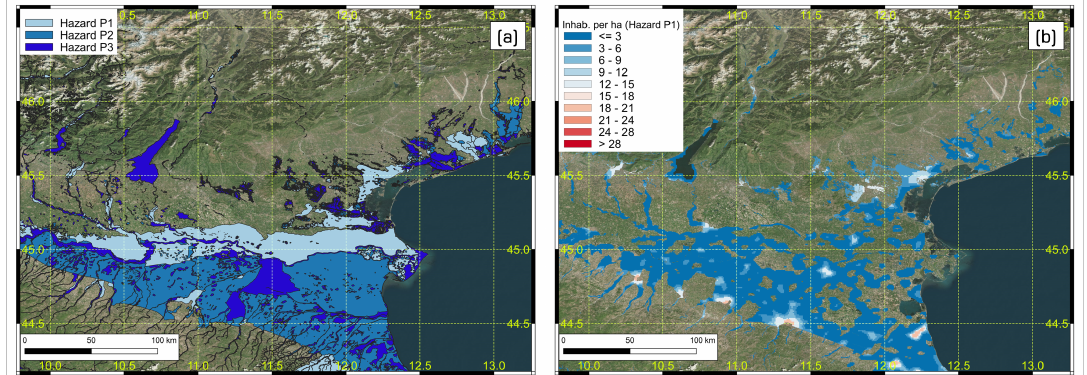
Figure 8. ( a ) ISPRA riverine flood hazard zones P1 (low probability), P2 (medium probability), and P3 (high probability) for North-East Italy and ( b ) the estimated number of exposed inhabitants per pixel in hazard zone P1 for the same zoomed-in